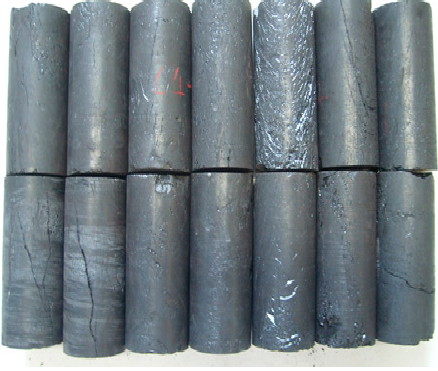
Figure 2. Coal samples as prepared for experiment.